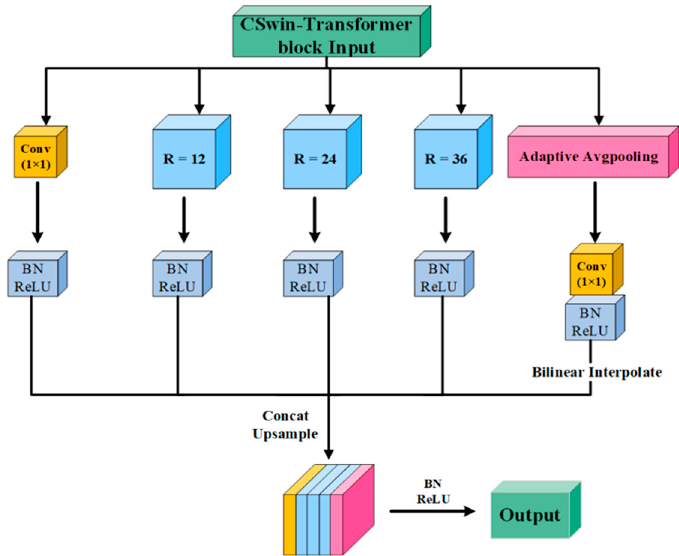
Figure 4. The overall architecture of the Global Context Module (GCM).